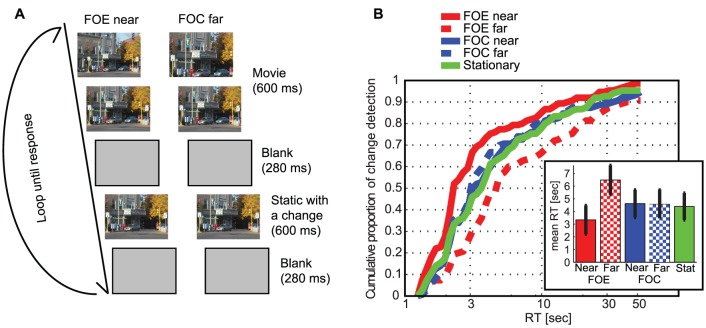
Expansion but not contraction influences the speed of change detection. (A) For Experiment 2, a 0.6 sec movie expanded or contracted with the associated FOE or FOC located either at the corner of the same quadrant as the change or at the opposite corner (in this example, the car on the bottom right disappeared). After a 0.28 sec blank period, a stationary image with a single noticeable change from the last frame of the movie was presented for 0.6 sec, followed by another 0.28 sec blank. This loop was repeated until subjects responded. (B) The cumulative detection probability as a function of RT (log scale). When the FOE was close to the location of the change, detection was facilitated, while when the FOE was far away, it interfered with change detection. Contraction did not affect change detection, compared to the control stationary condition. (Inset) Mean RT (error bars are for s.e.m.).